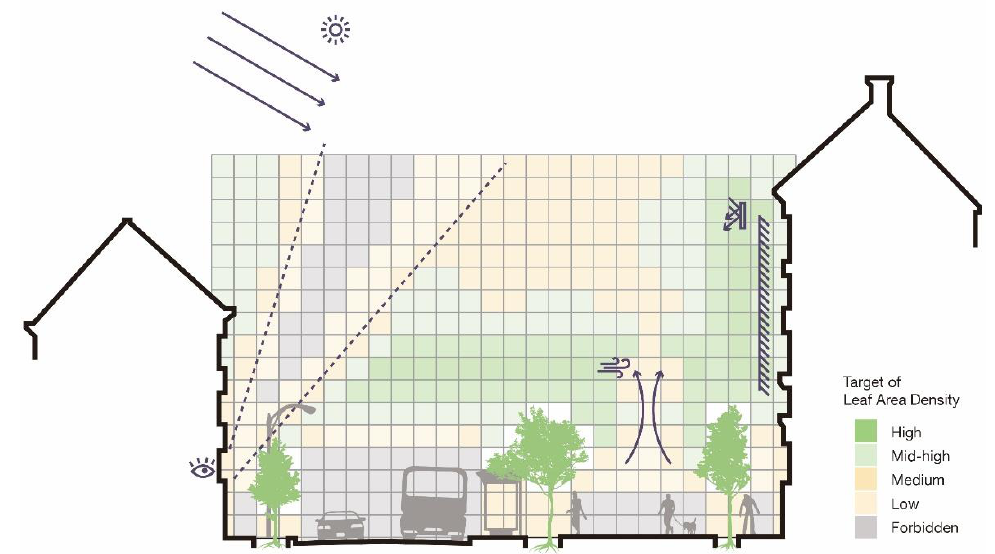
Figure 7. An example of designing street green space with voxels containing leaf area density: the north-facing apartments have access to sunlight and sky view; the motorway and south-facing façade are shaded against high radiation; ventilation at the sidewalk is not blocked. Designers can set target values such as rough leaf area densities to these voxels for various design purposes.